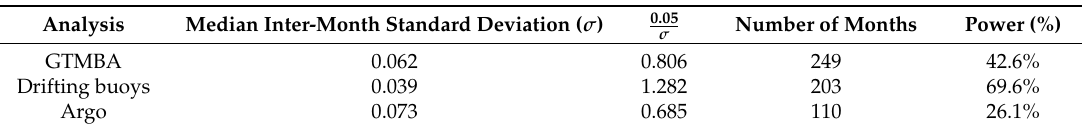
Table 7. Median standard deviation of the monthly mean differences calculated across the different ensembles, ratio of the target step size (0.05) to standard deviation, number of months with valid data and estimated power interpolated from Table 5 of Wang et al. [20].